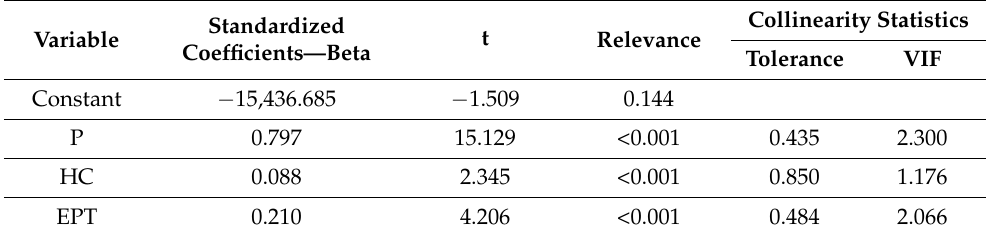
Table 10. Coefficients in the regression model of greenhouse gas emissions in 2012.